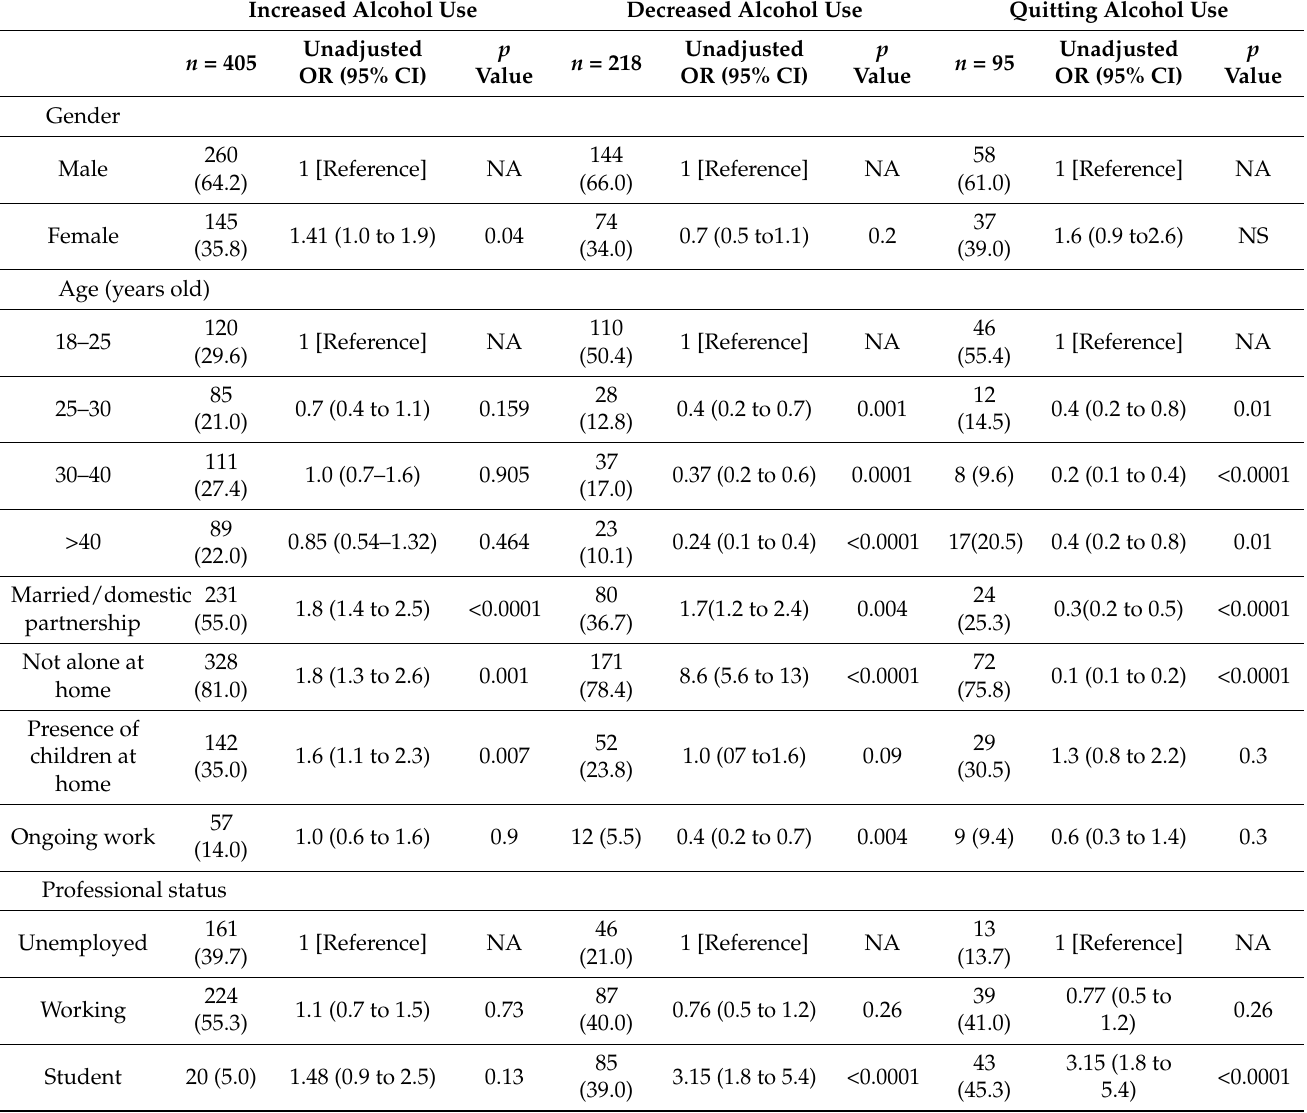
Table 3. Odds ratios (95% confidence interval) from univariate analysis for the association of socio- behavioral and health status variables with increased, decreased, and quitting alcohol